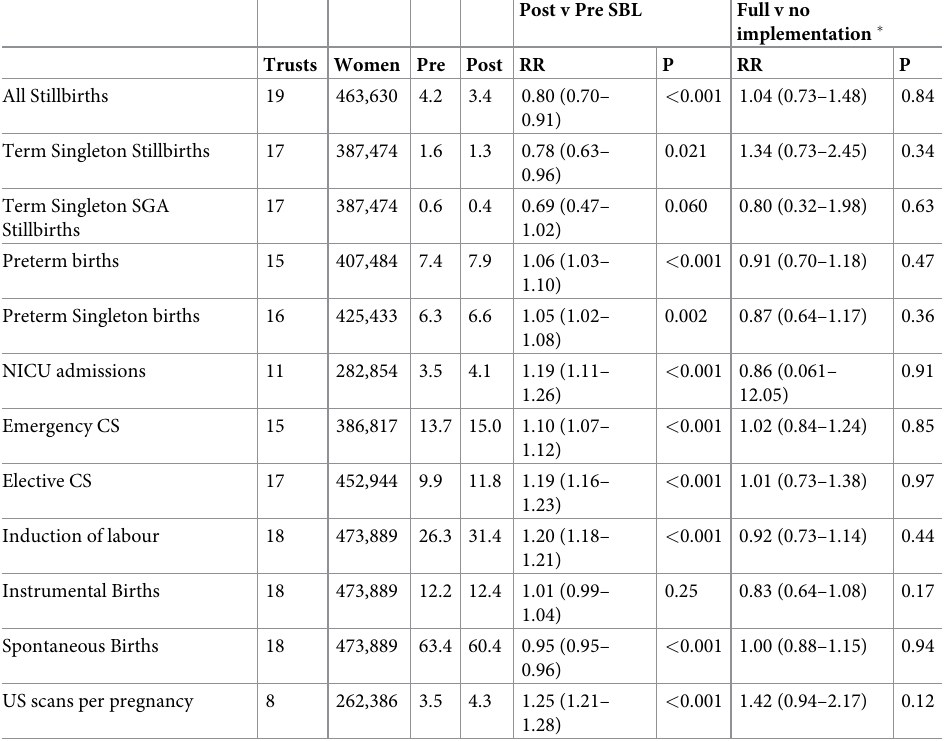
Table 2. Clinical and service outcomes.